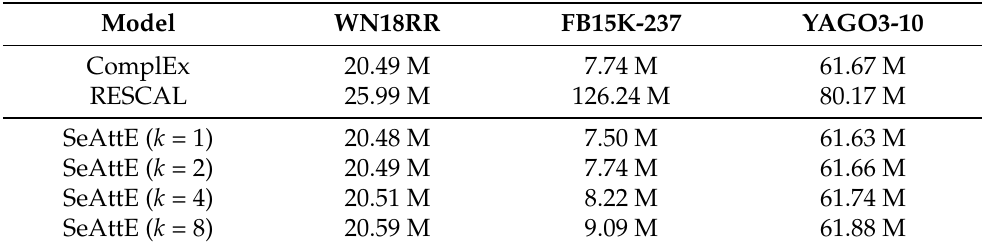
Table 7. This is the comparison of parameters between ComplEx, RESCAL and SeAttE, when entities have the same dimension ( d =